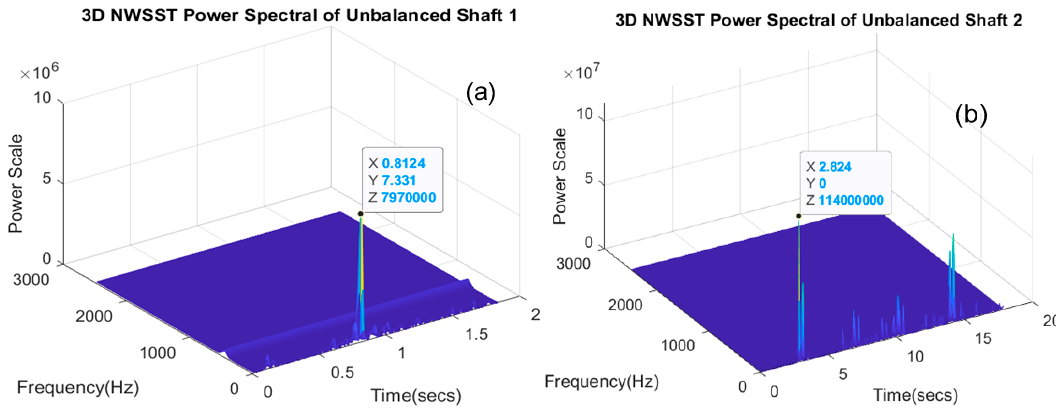
Figure 12. 3D experimental NWSST of ( a ) unbalanced driveshaft, ( b ) unbalanced driven shaft.